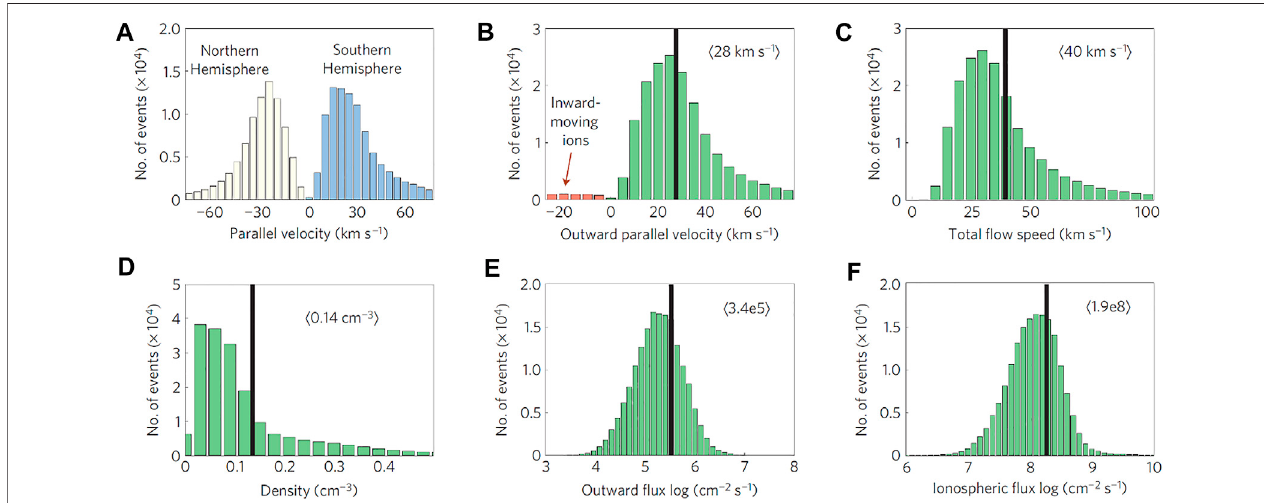
FIGURE 1 | Properties of cold ion out fl ow. (A) Parallel velocity. (B) Outward velocity aligned with the magnetic fi eld lines. (C) Total speed of cold ions. (D) Cold ion density derived from measurements ofspacecraft potential. (E) Out fl ow fl ux calculated from out fl owparallelvelocity times density with afact of0.8 for proton, assuming the out fl ow consists of 80% of protons. (F) Flux in the topside ionosphere mapped from the locations of Cluster to the altitude of 1000 km, where the strength of the magnetic fi eld is assumed to be 37 μ T. Adopted from [53].